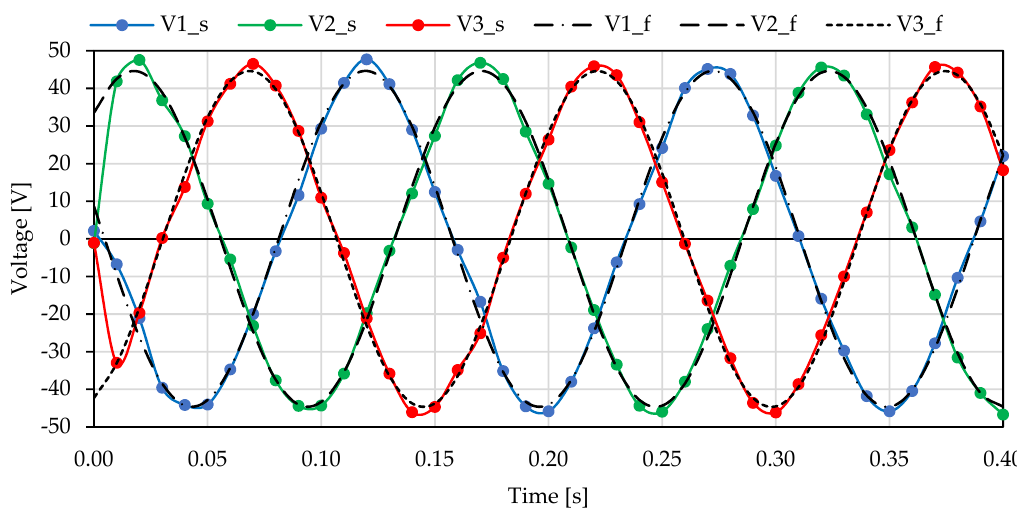
Figure 10. No-load voltages, considering a non-magnetic material in the stator.